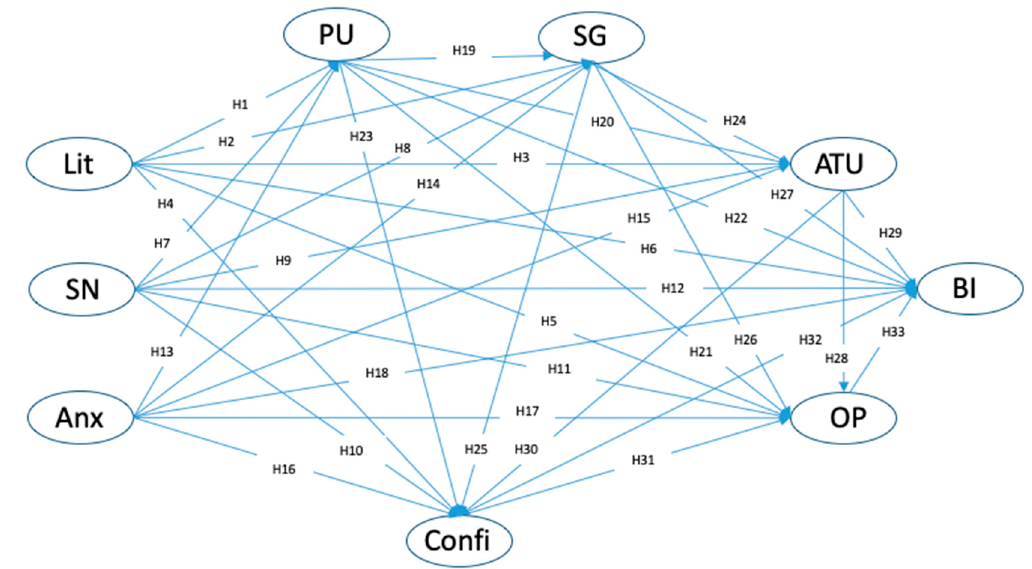
Figure 1. Hypothesized model. Note: Lit: AI literacy; SN: subjective norms; Anx: AI anxiety; PU: perceived usefulness; SG: AI for social good; ATU: attitude towards using AI; Confi: confidence in learning AI; OP: AI optimism; BI: behavioral intention.